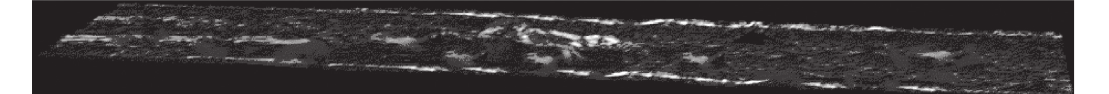
Figure 5: Frame difference between the frame and (i) the first frame of the video sequence containing an empty lane. Swimming Championships in Limoges, France, April 2015.